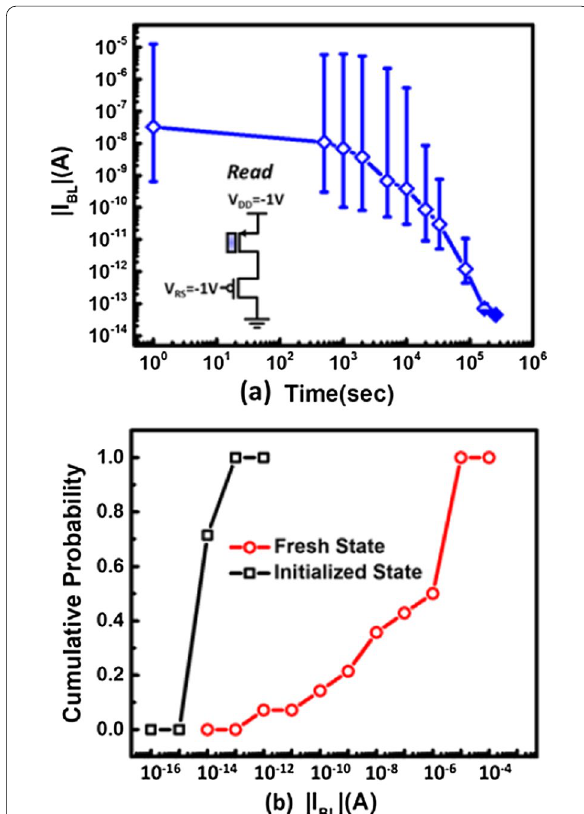
Fig. 4 a The distribution of BL current will be tightened after baking in 250 °C for more than 100 k seconds and b the cumulative plot indicates read current converge to below 0.1pA which further ensure